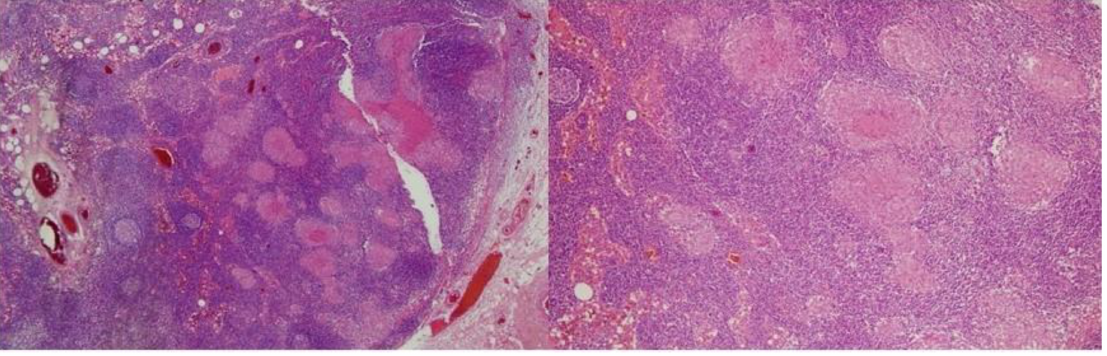
Figure 2. The histopathologic evaluation of the left cervical modified radical type 3 dissection material showing caseous granulomatous